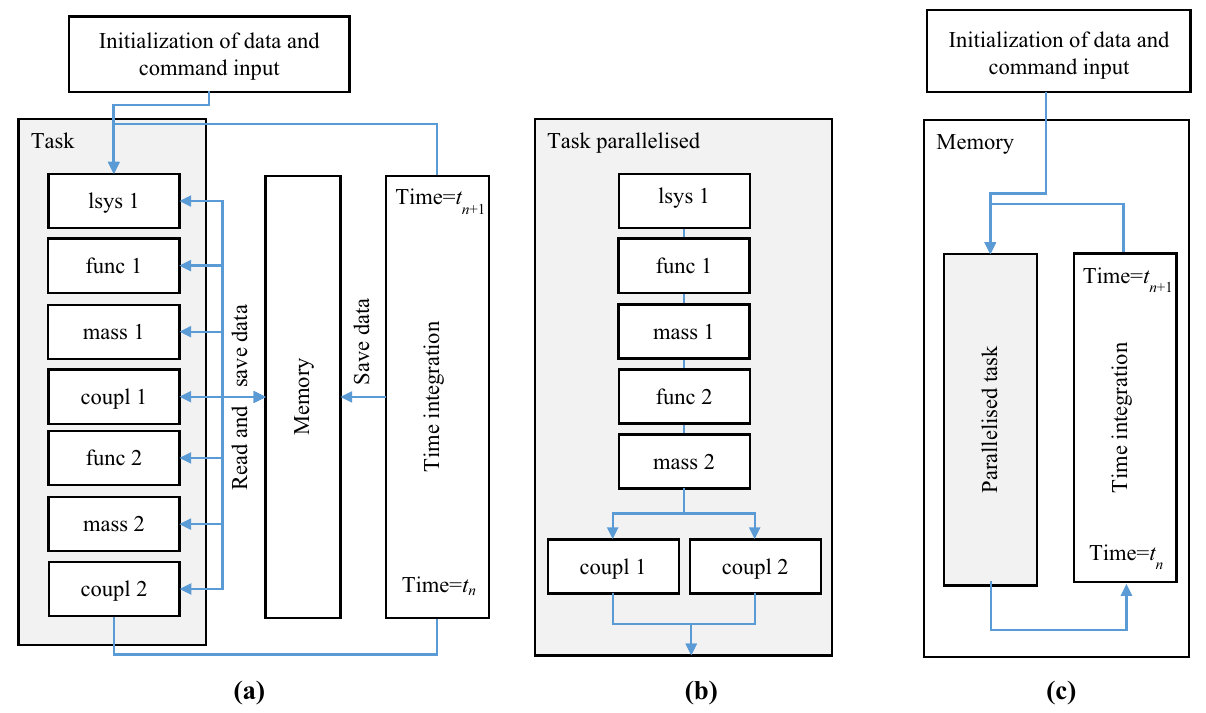
Fig. 9 Time-domain simulation in Gensys: a original serial computing-based numerical steps, b parallel computing-based numerical steps, c parallel computing using RAMdisk